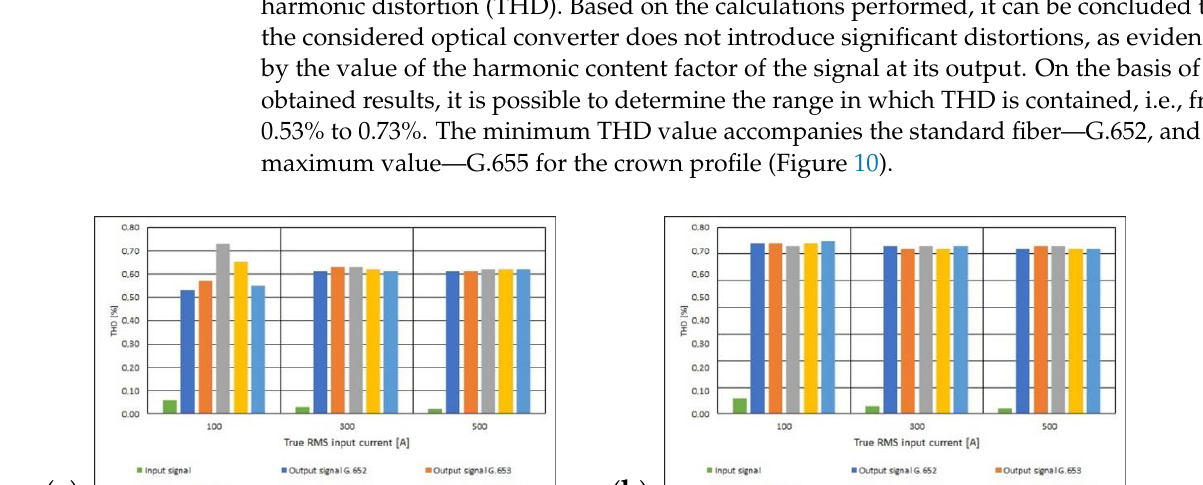
Figure 9. Values of the m th DFT input component (500 A True RMS) and output component for the different standards of single mode telecommunications fibers [own results]: ( a ) for 40-turns measuring coil and ( b ) for 80-turns measuring coil.